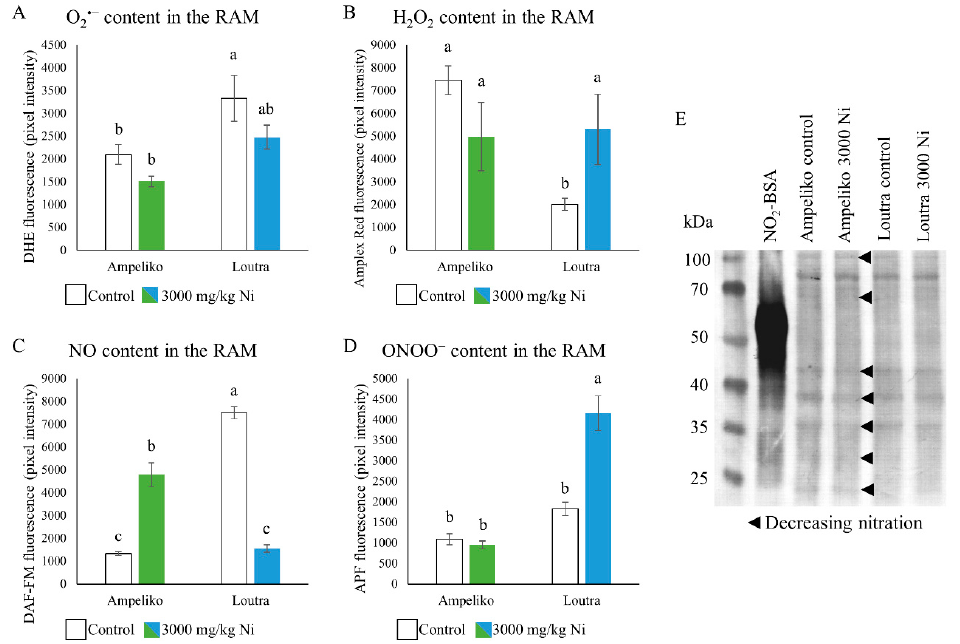
Figure 3. Changes in the fluorescence consistent with superoxide ( A ), hydrogen peroxide ( B ), nitric oxide ( C ) and peroxynitrite ( D ) in the root apical meristem (RAM) of O. lesbiaca from the two different habitats. Representative immunoblot showing nickel-induced changes of protein tyrosine nitration in the roots of O. lesbiaca from the two different habitats ( E ). Arrows show lowered nitration compared to the control. Different letters indicate significant differences according to Duncan-test ( p < 0.05), n.s. means no significant difference.